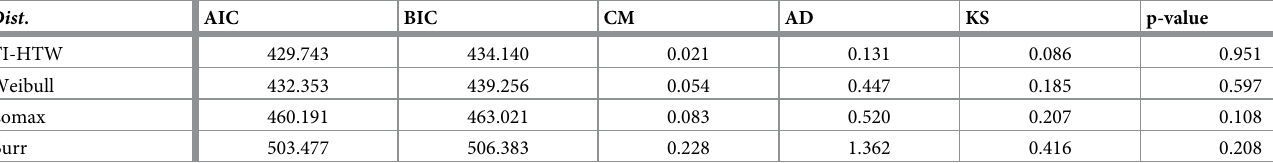
Table 12. Analytical measures of the TI-HTW and other competing models for data 3. Dist .